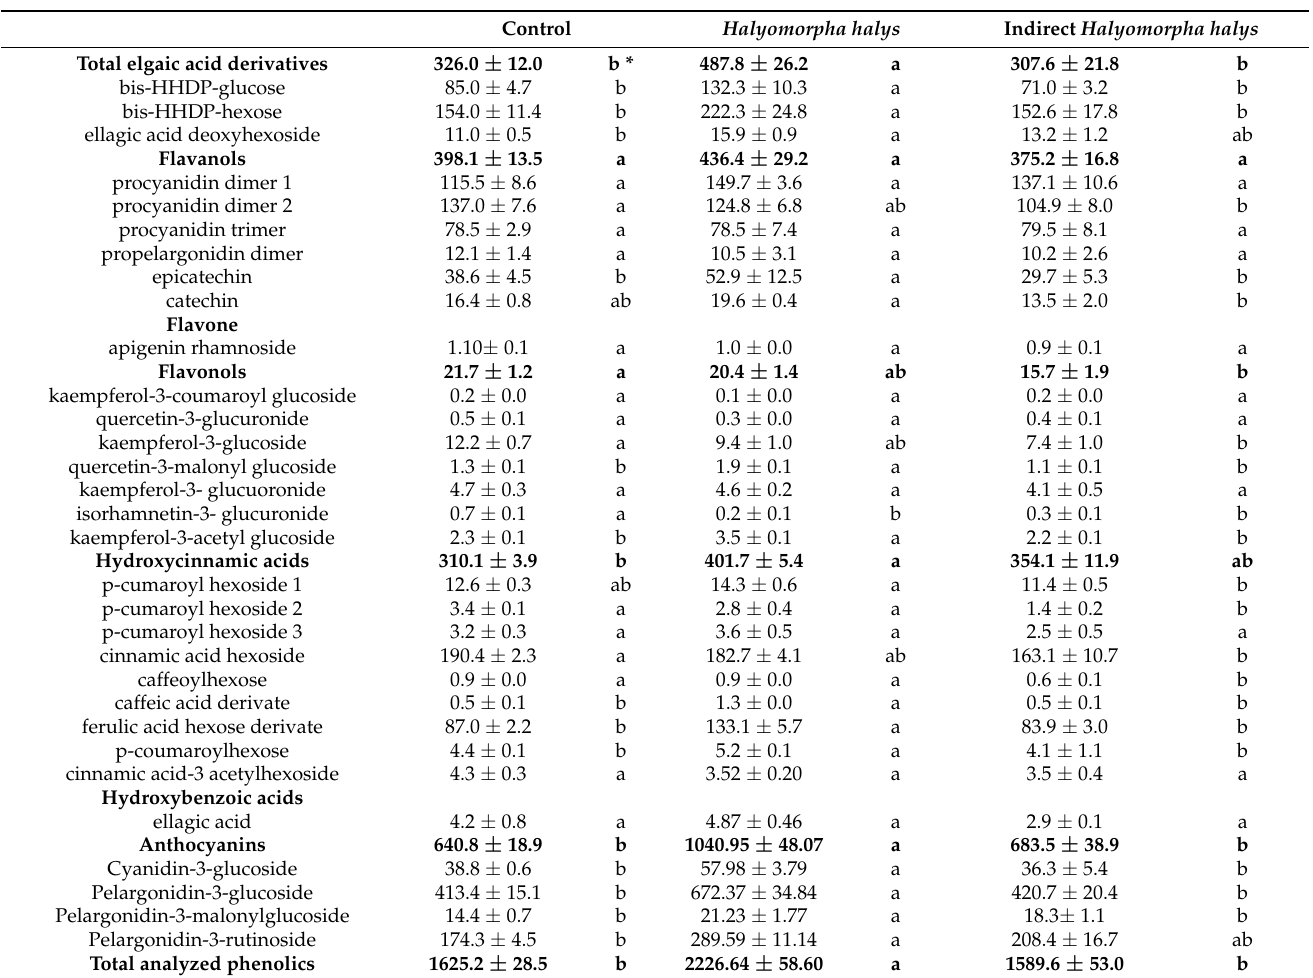
Table 3. Individual and total phenolic content (mg/kg FW, mean ± SE) in strawberry fruit. Control Halyomorpha halys Indirect Halyomorpha halys